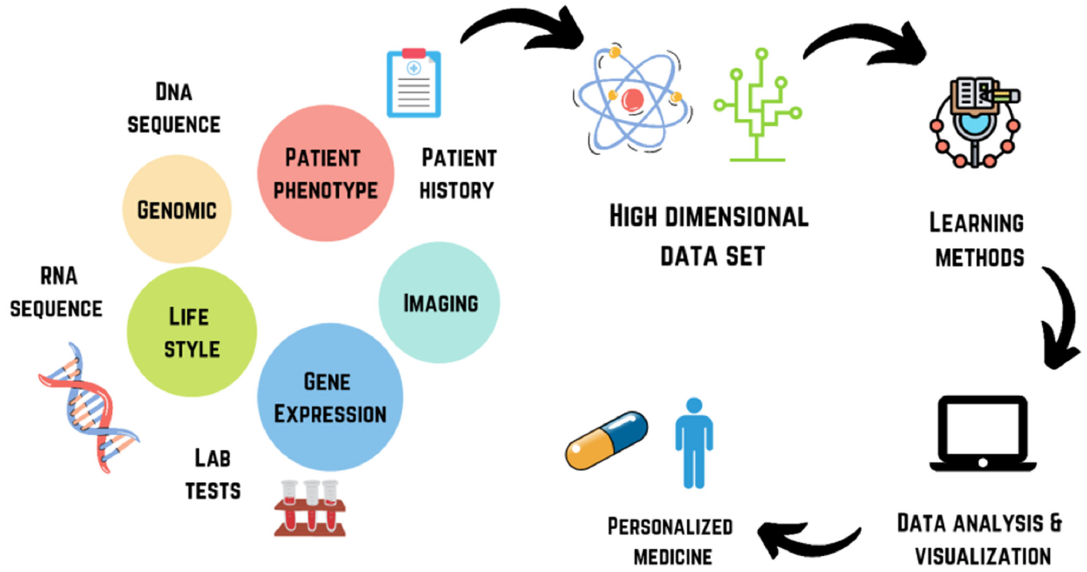
Figure 1. AI in acquiring and analyzing data of a patient in personalizing the treatment.